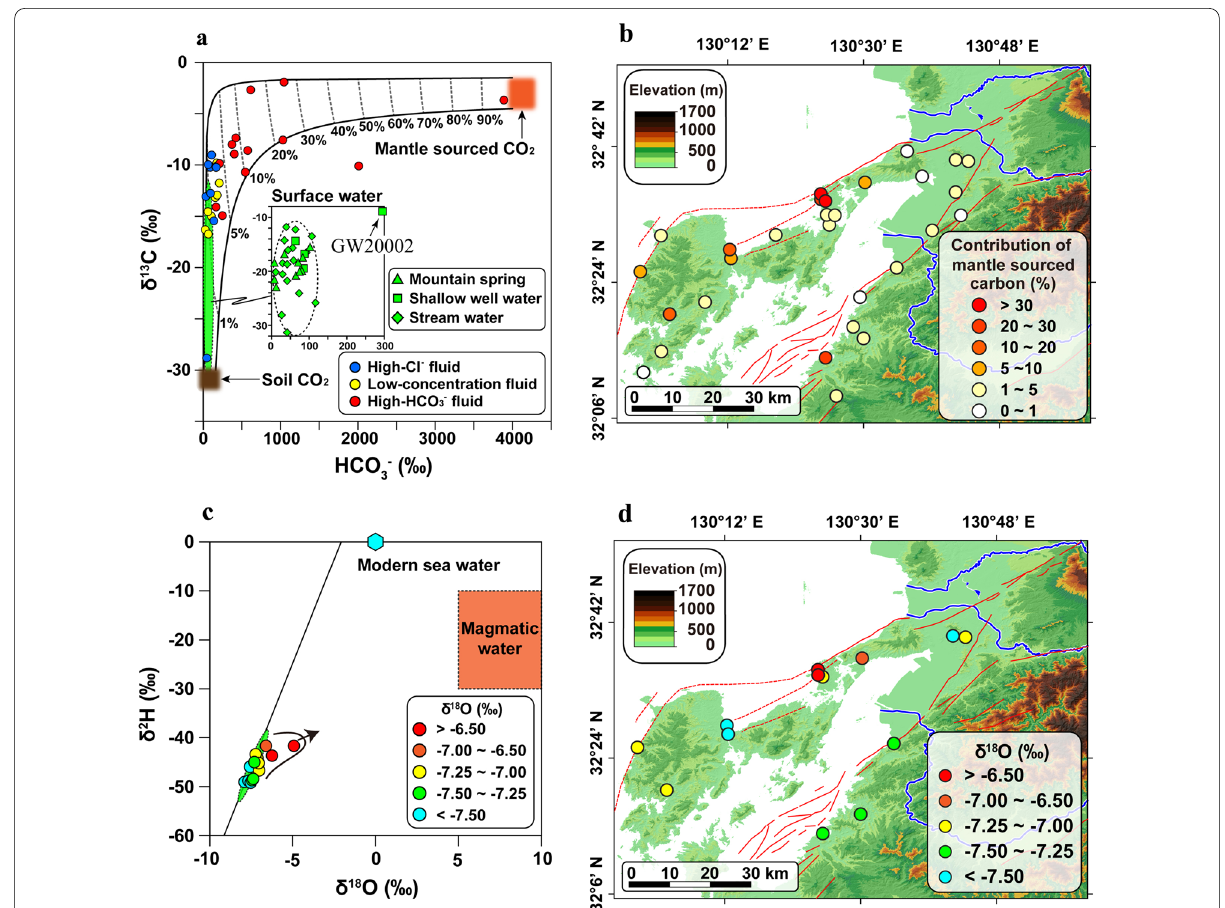
Fig. 6 Identification for deeply originated components. a HCO 3 − concentration versus δ 13 C diagram for all collected water samples. Simple two components mixing curved lines with relative contribution rates from hypothesized mantle sourced carbon in 10% interval are shown in the graph. Mixing of two sets of end-components, soil carbon (HCO 3 − and δ 13 C: 20 mg/l and 30‰, 160 mg/l and 30‰, respectively) and mantle sourced − − carbon (HCO 3 − and δ 13 C: 4,000 mg/l and 4.5‰, 4,000 mg/l and 1.5‰, respectively) were hypothesized taking compositional variations − − observed from this study, with a same method applied elsewhere (e.g., Chiodini et al. 2000; Yamada et al. 2011; Rive et al. 2013). b Geographical distribution of relative contribution from mantle sourced carbon in groundwater samples deduced from mixing model shown in panel a . c δ 2 H versus δ 18 O plot diagram for High-HCO 3 − fluid shown in different colors with variable δ 18 O. d Geographical distribution of δ 18 O values. The symbol color is same as in panel